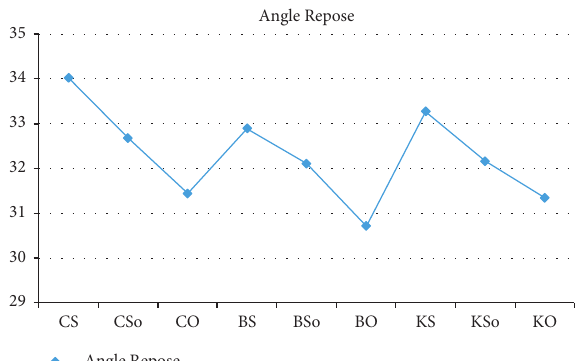
Figure 3: Angle repose of anchote flours. CS: control and sun-dried sample, CSo: control and solar-dried sample, CO: control and oven- dried sample, BS: blanching and sun-dried sample, BSo: blanching and solar-dried sample, BO: blanching-oven-dried sample, KS: potassium metabisulphite and sun-dried sample, KSo: potassium metabisulphite and solar-dried sample, and KO: potassium metabisulphite and oven- dried sample. Table 3: Color properties of anchote flour as affected by pretreatments and drying methods.